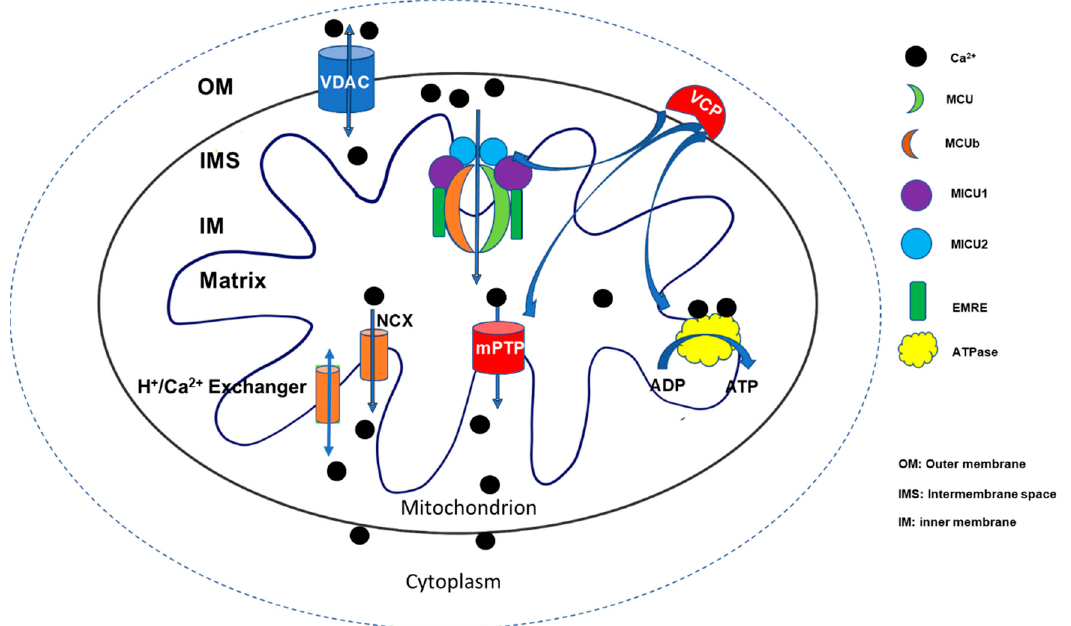
Figure 1. Summary of the regulation in mitochondrial Ca 2+ homeostasis. Two major regulatory systems participate in regulating mitochondrial Ca 2+ homeostasis by releasing Ca 2+ into the cytosol or up-taking Ca 2+ from the cytosol. Ca 2+ enters the mitochondrial intermembrane space (IMS) via voltage-dependent anion channel 1 (VDAC1) and is then transferred into the mitochondrial matrix through a mitochondrial Ca 2+ uniporter (MCU) by interacting with a variety of regulatory proteins, such as calcium uptake proteins (MICUs), as well as essential MCU regulators (EMRE) to constitute a comprehensive functional complex that controls the uptake of Ca 2+ . On the other hand, the Ca 2+ stored in the matrix can be pumped back to IMS through Na + /Ca 2+ (NCX) or H + /Ca 2+ exchangers and mitochondrial permeability transition pore (mPTP) openings. Ca 2+ participates in multiple energy